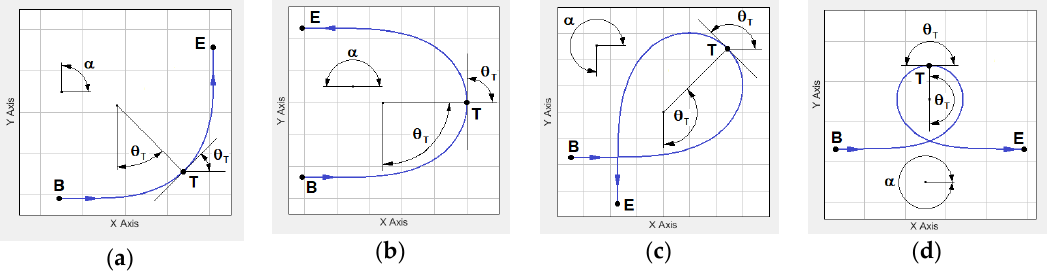
Figure 3. The analyzed motion paths: ( a ) “half of lambda” (HoL); ( b ) “half of chi” (HoC); ( c ) “rho” (RHO); ( d ) “omega” (OMG). Due to the fact that velocities, accelerations, and jerks are determined as the first, second, and third displacement derivatives in relation to time, the simulation was made in the time domain. substitution l=v max τ and dl=v max dτ into relation (3), rectangular coordinates of any point of the single transition curve in the function of time t are obtained from: